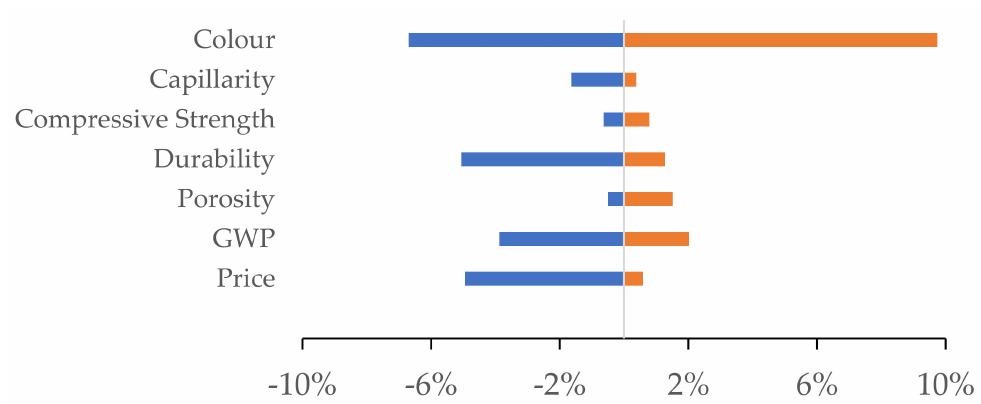
Figure 6. Sensitivity analysis of the effect of criteria on the total score. Low and high scenarios correspond to those defined in Table 4.